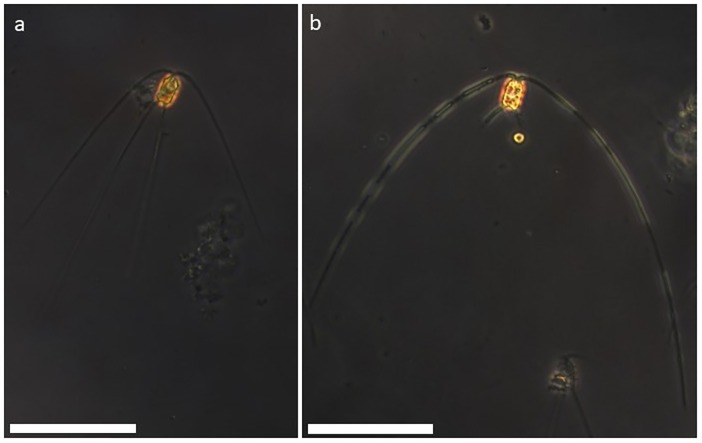
Light microscopy of C. peruvianus.Cells of C. peruvianus grown in F/2 medium (a) and in P-limit medium (b). Note the thickened and elongated setae of the cell grown in P-limit medium (b). Scale bar represents 20 μm.